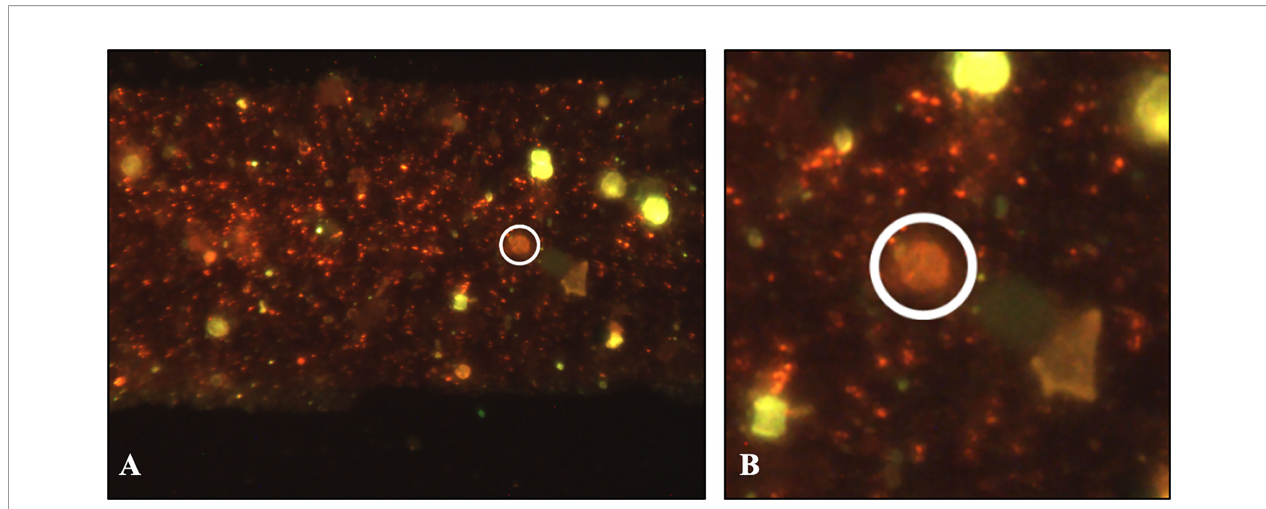
FIGURE 3 | Innosieve grid detection by using an A. fumigatus speci fi c fl uorescent staining, the MuScan camera is able to identify both conidia (green fl uorescence, A ) as well as ascospores (red fl uorescence, in white circle, A and enlargement B ) within the dense layer of a fl ower bulb waste material (sample